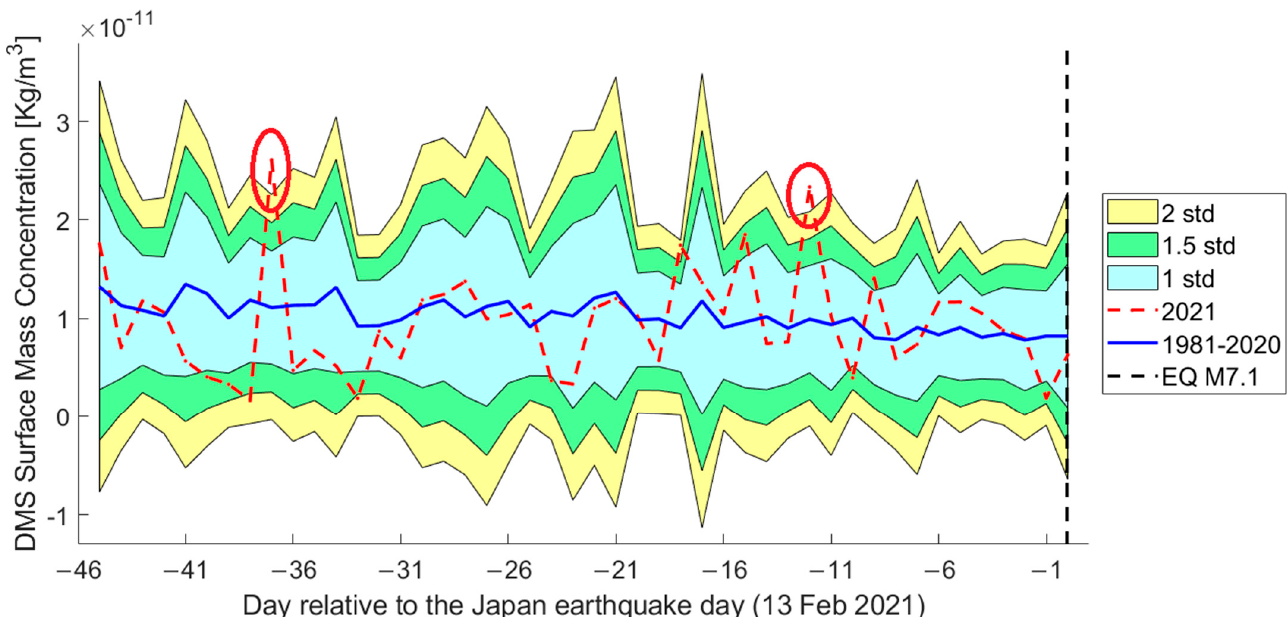
Figure 15. Atmospheric analysis of dimethyl sulphide (DMS) concentration in the 45 days before the Mw = 7.1 Japan 13 February 2021 earthquake in a square area of 3° size centred on the epicentre. We highlight the anomalies with bold red circles, as significant and more robust anomalies.